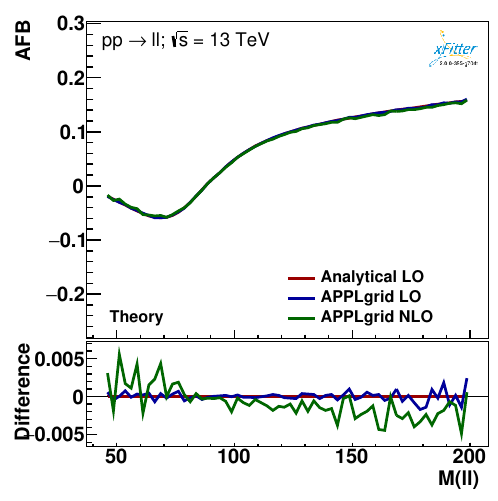
Figure 1 . The A (cid:3) invariant mass distribution output of xFitter obtained for the HERA- FB PDF2.0nnlo PDF set with the independent analytical code as well as with the grids computed with MadGraph5 aMC@NLO at LO and